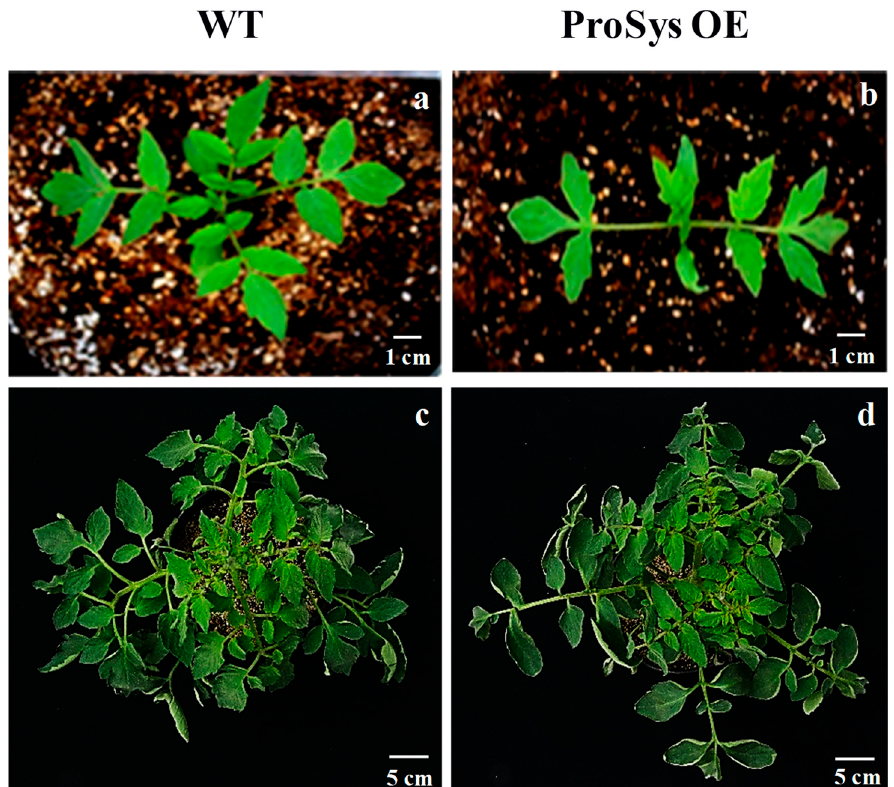
Figure 1. Growth and morphology of prosystemin overexpressing tomato plants. Compared to ( a ) wild-type (WT) untransformed tomato plants, ( b ) plants overexpressing the prosystemin (ProSys-OE) precursor of the systemin peptide hormone had a retarded growth at early developing stages (the images show plants 3 days post transplantation (dpt) into pots). In older plants, recorded 33 dpt, ( c ) WT plants were shorter, had a lower number of leaves and were compacter and morphologically different to ( d ) ProSys-OE plants.